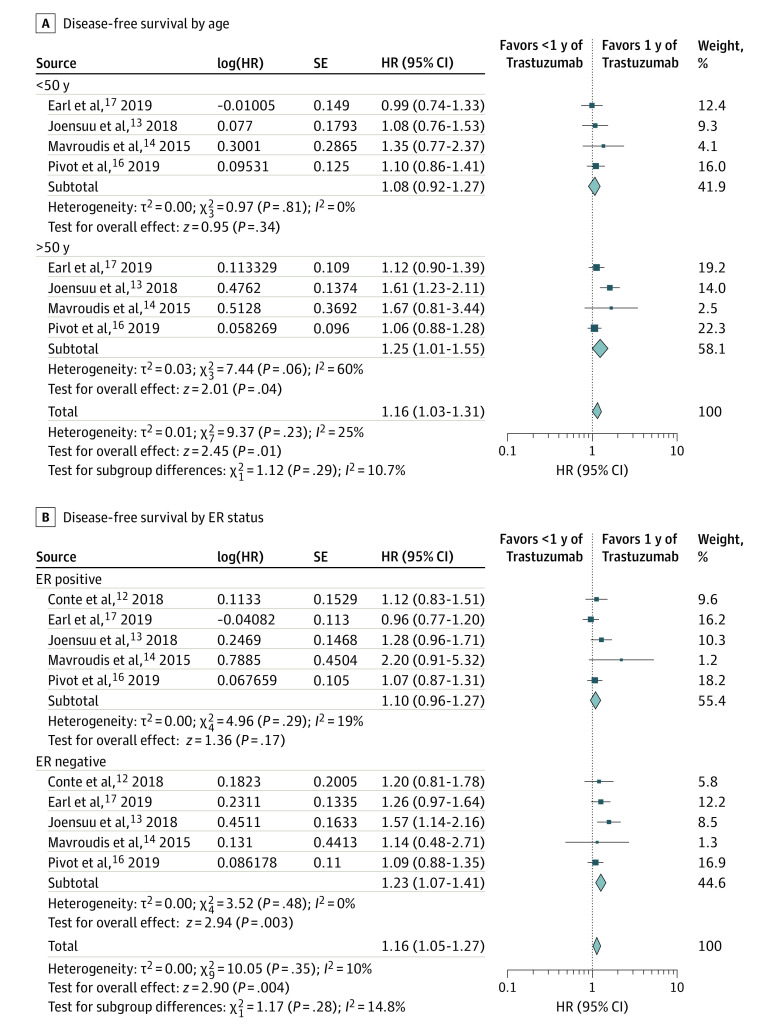
Hazard Ratio (HR) Plots for Disease-Free Survival by Age and Estrogen Receptor StatusThe number of events in subgroups are based on data in eTable 7 in the Supplement.